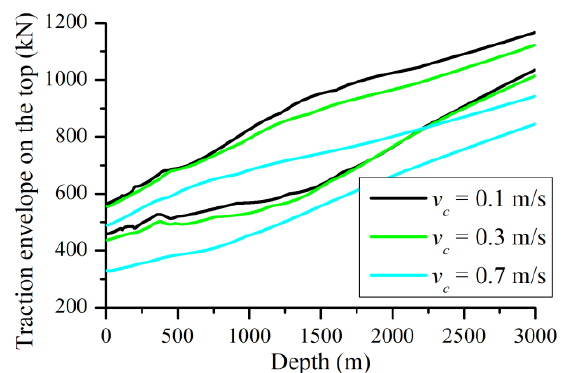
Figure 7. Traction at the top of the cable in the lowering process, considering different lowering velocities (0.1, 0.3, or 0.7 m/s).